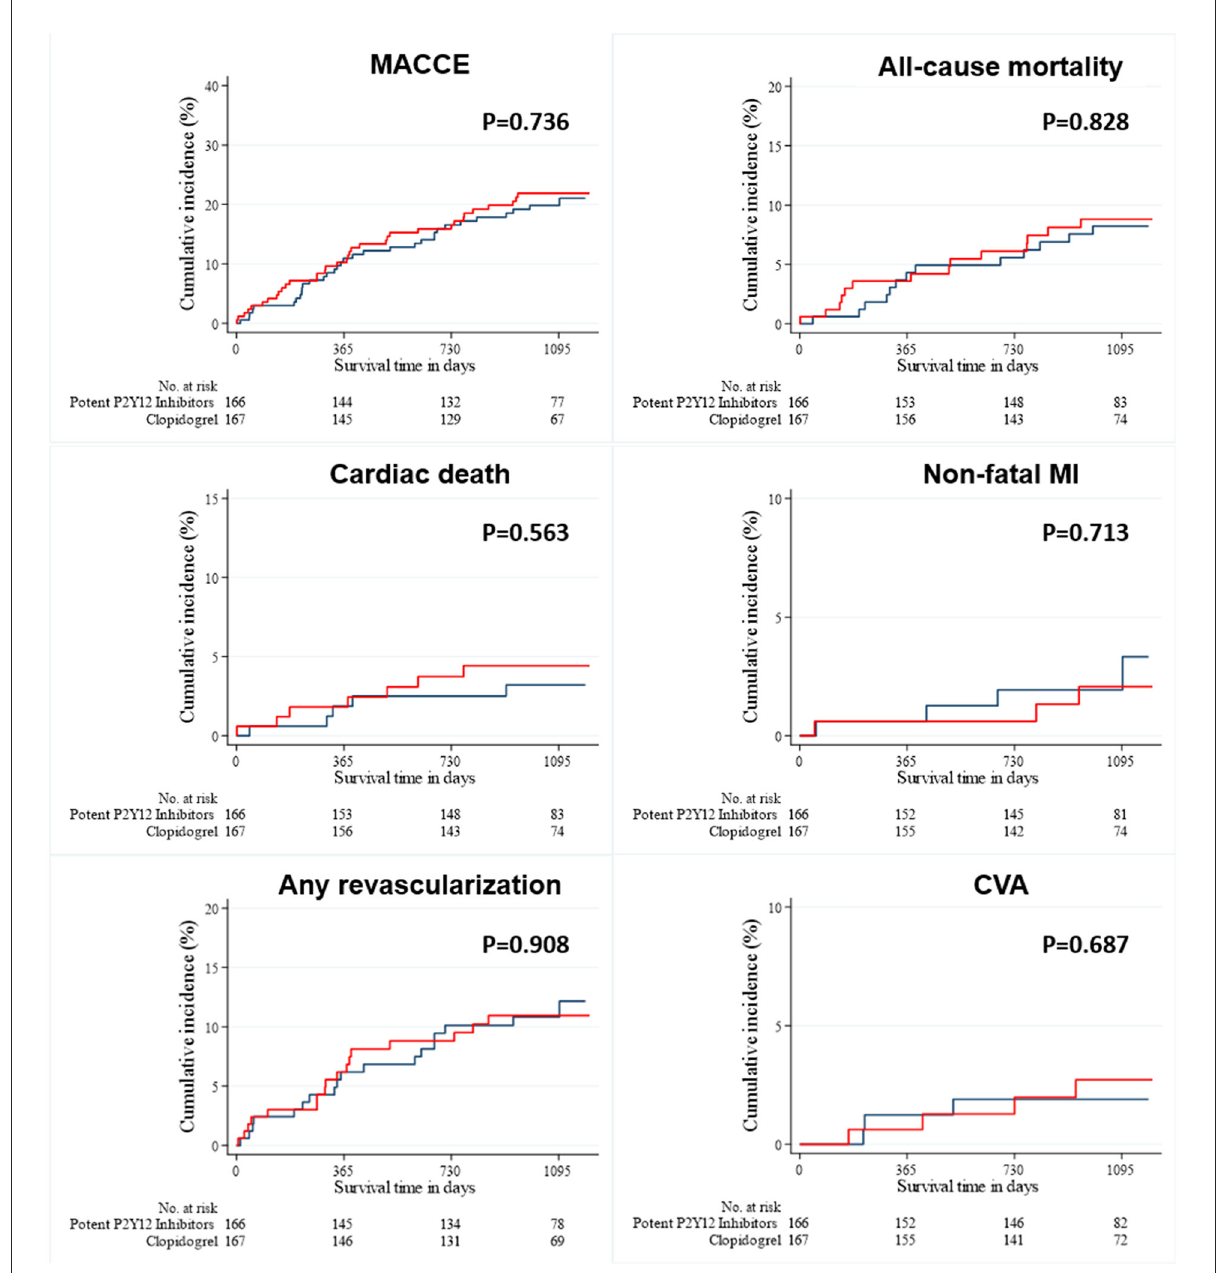
FIGURE3 Event rates of clinical outcomes for all patients after a 3-year follow-up (after PSM-adjusted analysis). The Kaplan–Meier curves for cumulative event rates according to the type of P2Y12 receptor inhibitors are shown. The red curve indicates group A, and the blue curve indicates group B. CVA, cerebrovascular accident; MACCE, major adverse cardiac and cerebrovascular event; MI, myocardial infarction; PSM, propensity score